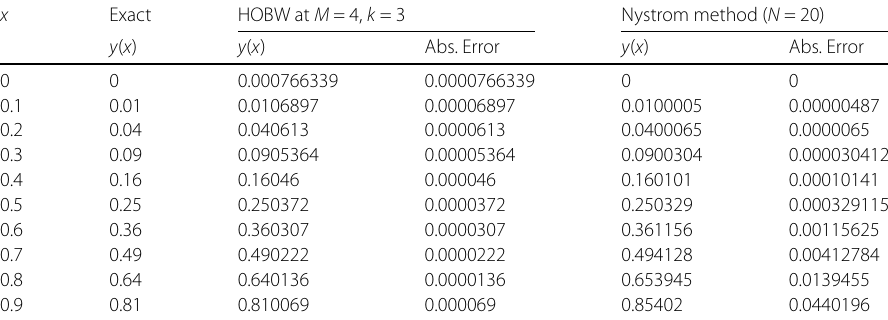
Table 2 Comparison of HOBW results and Abs. Error for Example